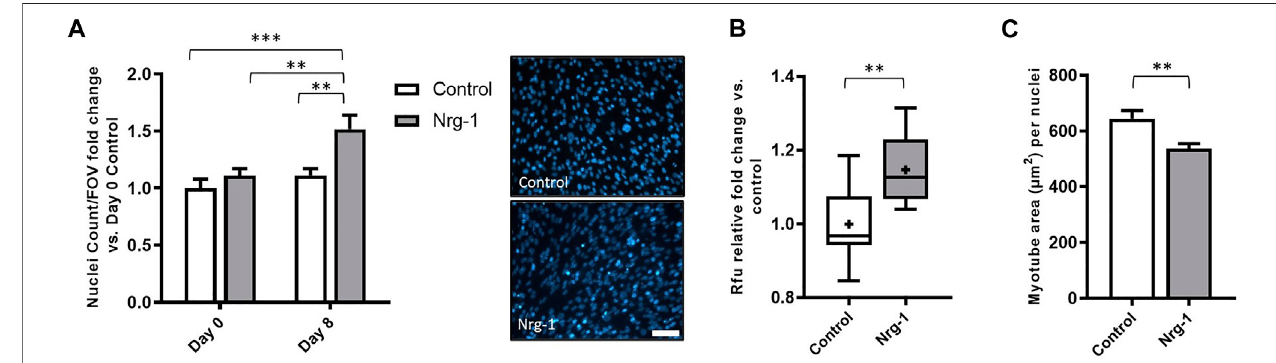
FIGURE 7 | Nrg-1 treatment leads to cell proliferation during the differentiation phase in C2C12 cells. (A) Nuclei cells counts from day 0 and day 8 in both control and Nrg-1 treated myotubes relative to Day 0 control. To the right, representative fl uorescent micrographs with Hoechst stain in blue (scale bar, 200 µm). (B) Rfu fold changerelativetocontrolfromPrestoblue TM cellviabilityassay. (C) Averagemyotubearea(µm 2 )permyonuclei(usingmyotubedatasetfrom Figure6 ).Mean ± SEM, n (cid:1) 9, ** p < 0.01, *** p <